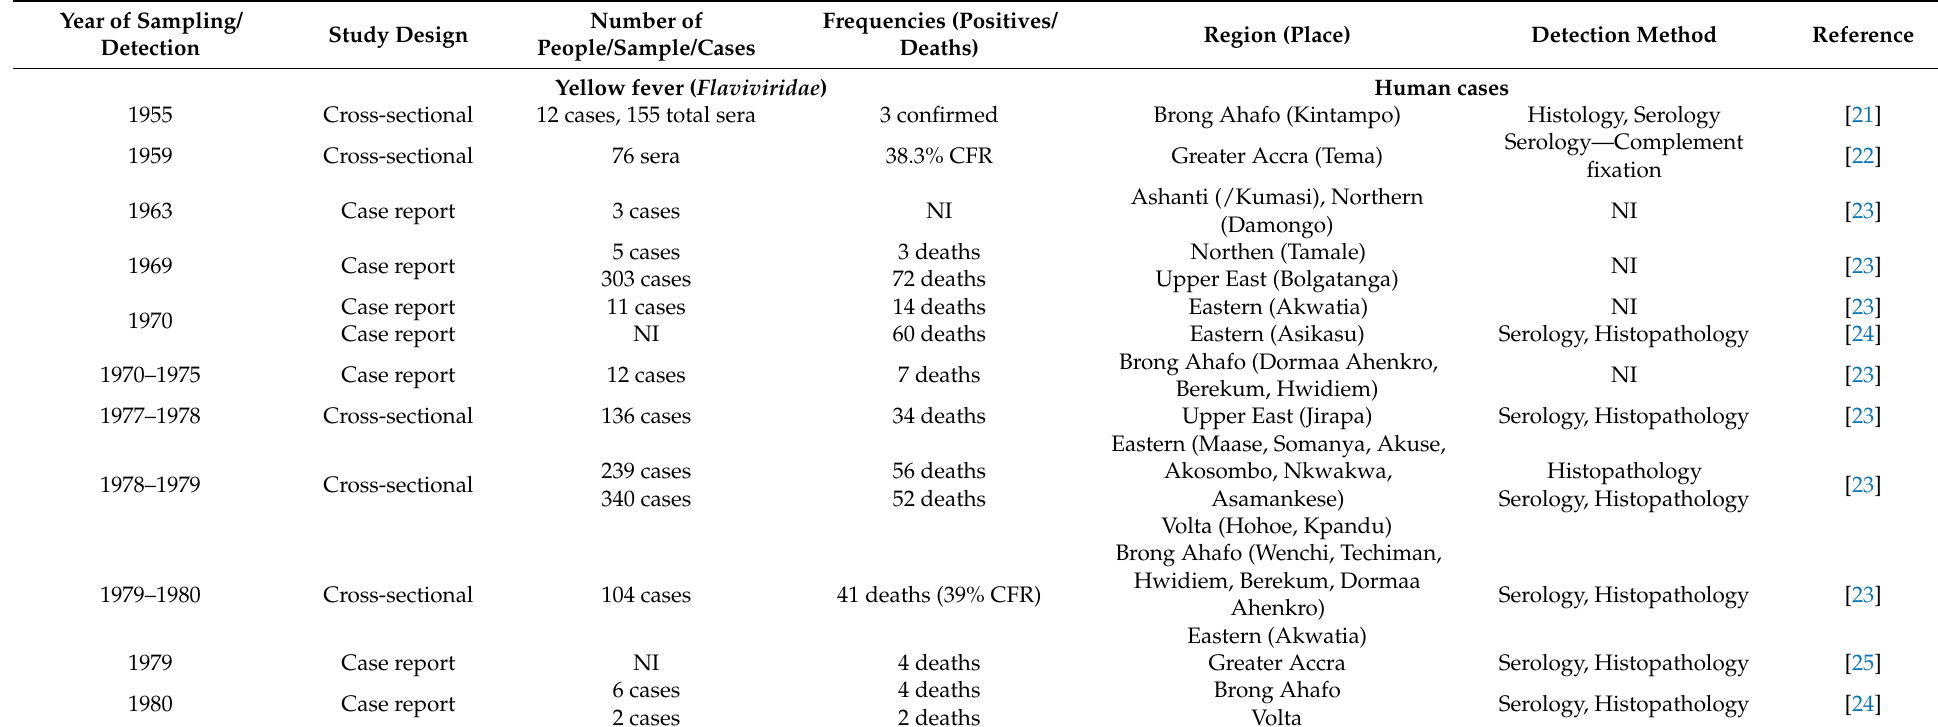
Table 1. Arboviruses investigated in Ghana